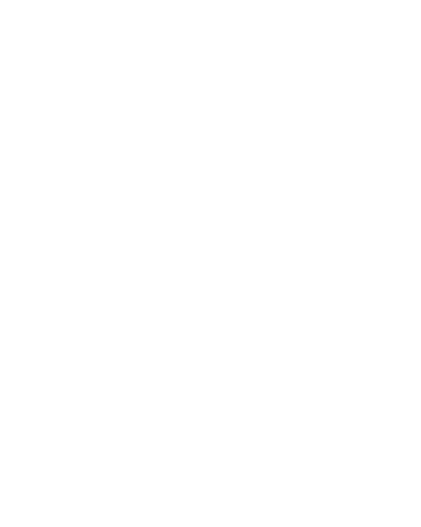
Table 2. Parameters by Metropolitan Statistical Area